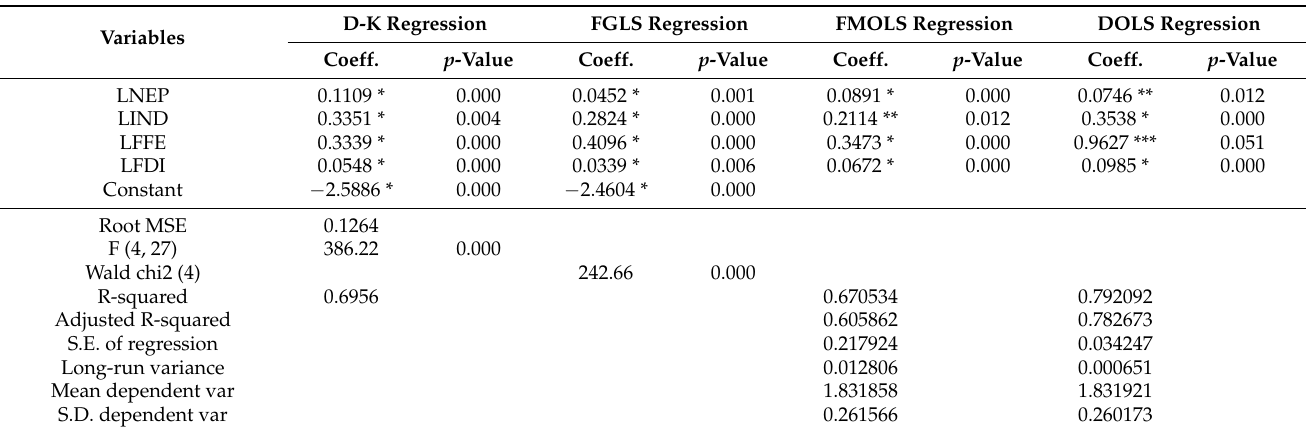
Table 7. Results of long-run elasticity